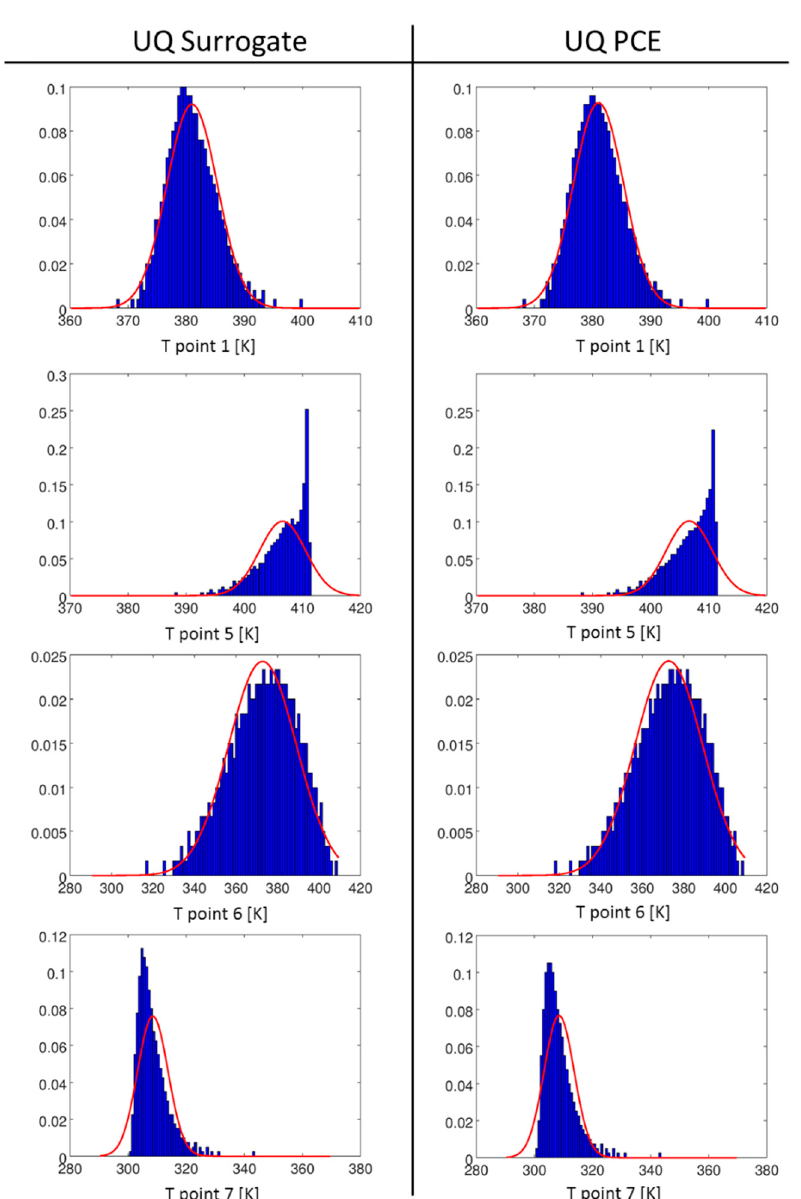
Figure 25. Comparison between surrogate-based and PCE results for certain QoI - wind direction.